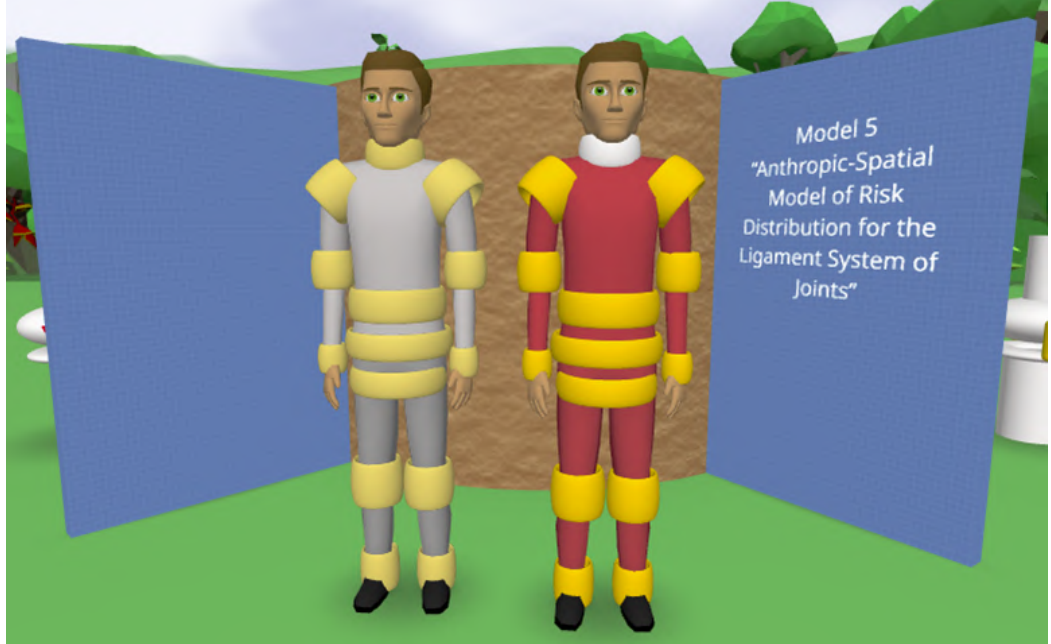
Figure 13: “Virtual Model of Identifying the Risks for Locomotor Apparatus Caused by Ligament Stretching”: Model 5 – “Anthropic-Spatial Model of Risk Distribution for the Ligament System of Joints”